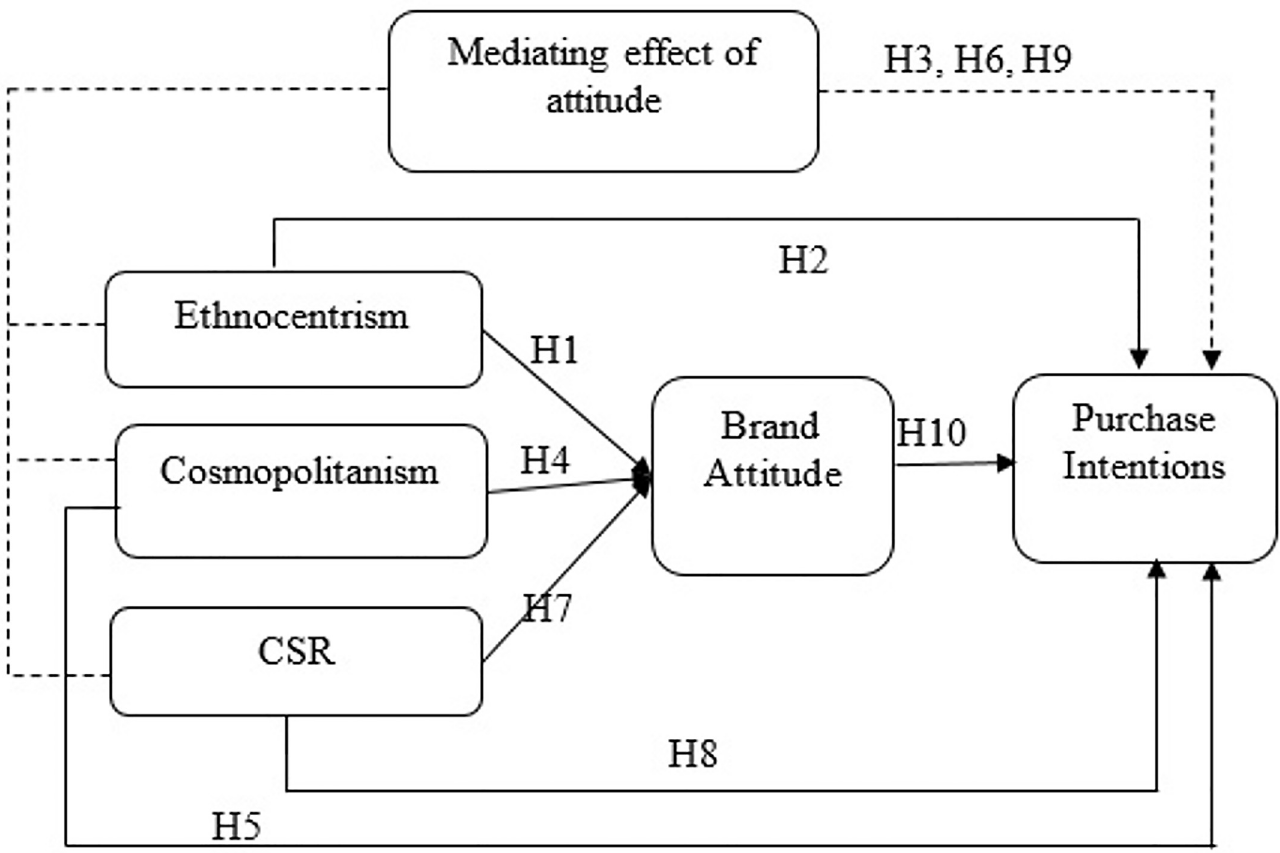
Fig 1. Conceptual framework: Author’s elaboration.